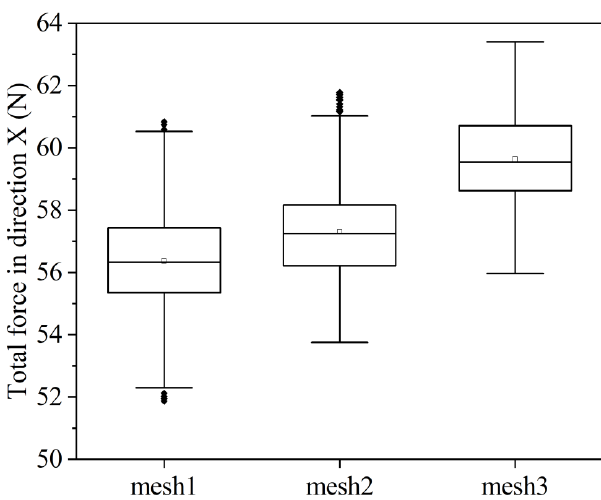
Figure 3. Vertical cross-section view of mesh2.